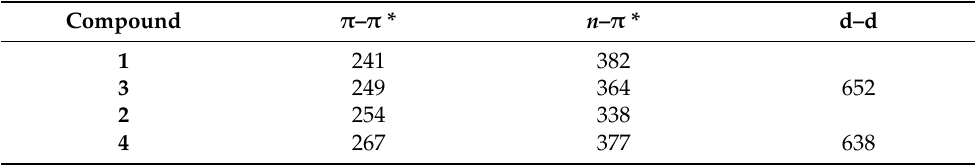
Table 4. Electronic spectral data (nm) of the ligands and their